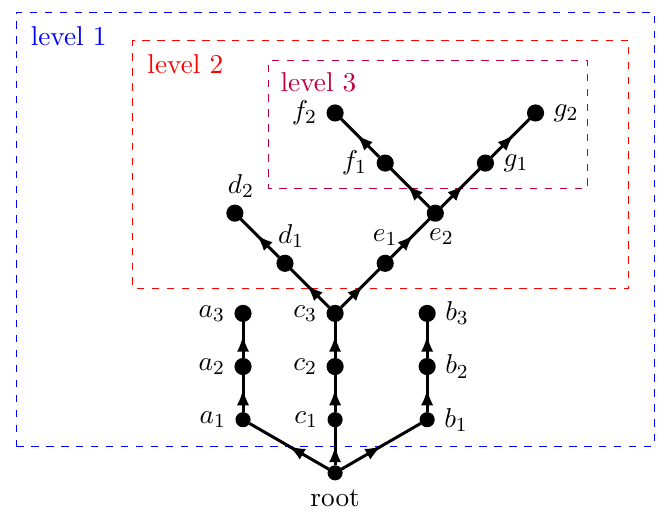
Figure 1 . The rooted tree with three